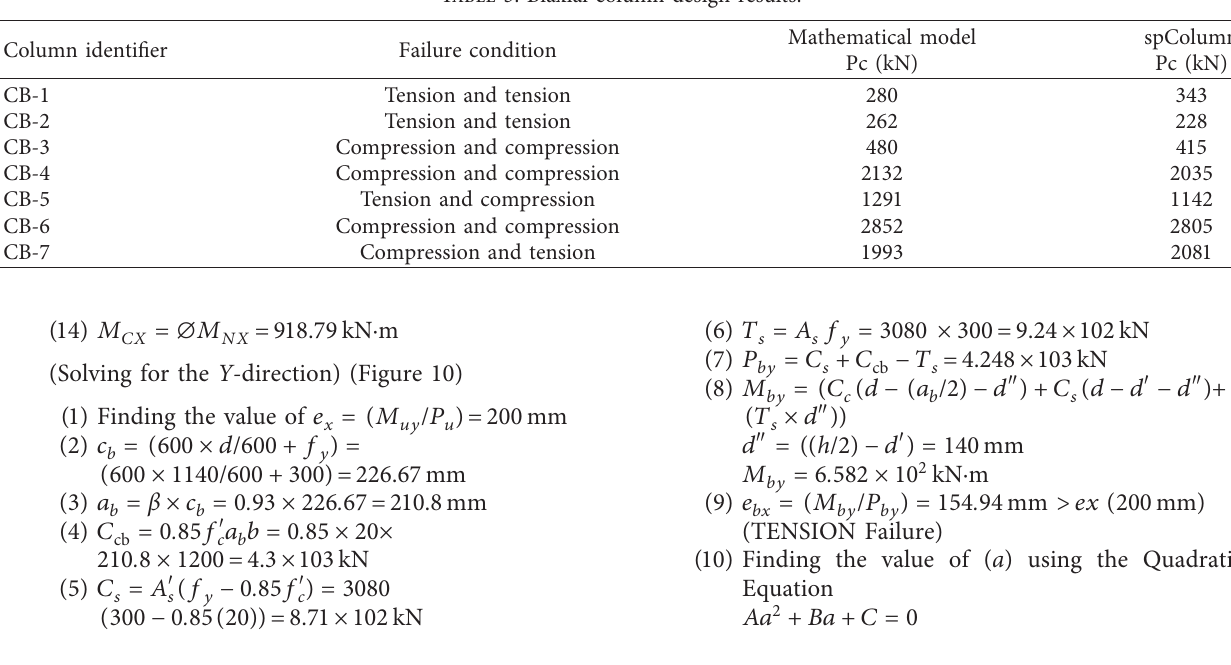
Table 5: Biaxial column design